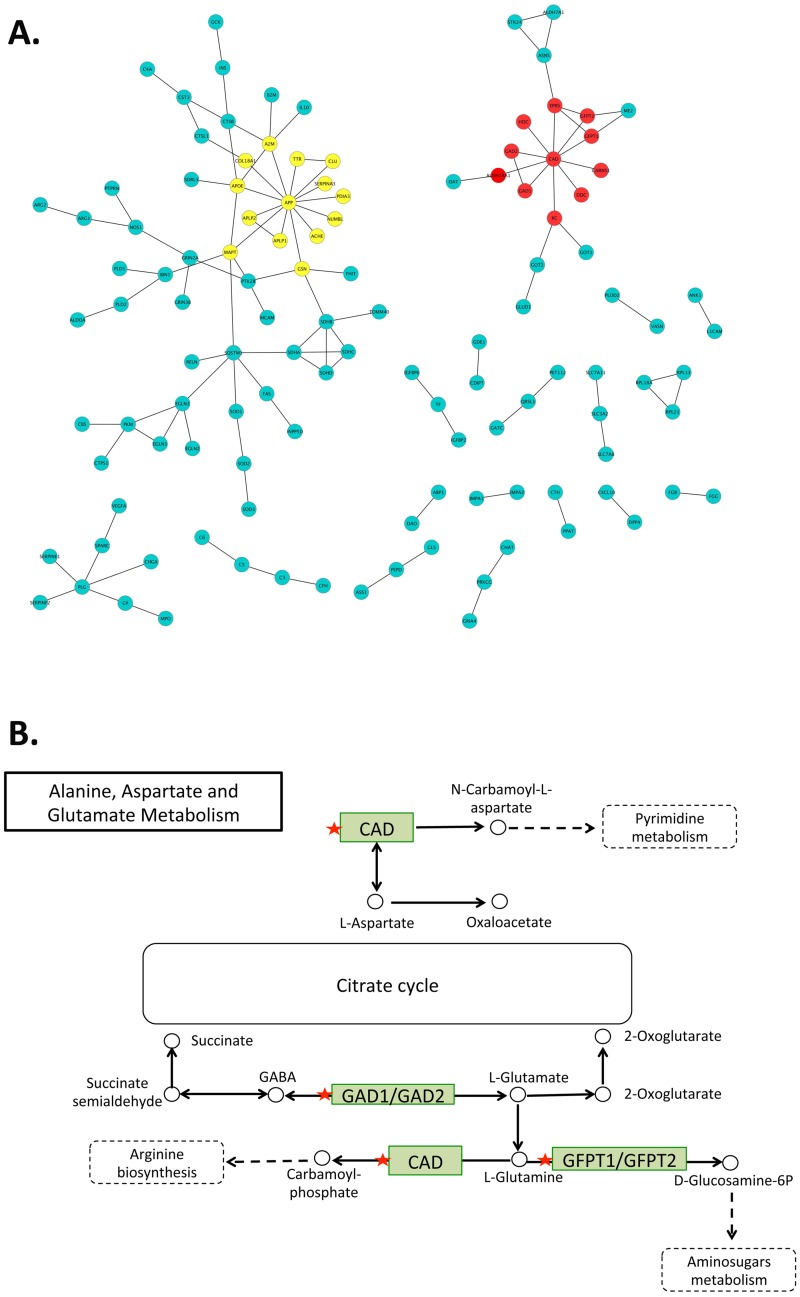
A) Protein-protein interaction analysis of 524 AD-related proteins revealed two large protein clusters: the APP network (14 yellow nodes) and the CAD network (11 red nodes). B) The functional enrichment analysis found that five proteins (labeled with red stars) of the CAD network are involved in the “Alanine, Aspartate and Glutamate Metabolism” pathway (CAD, GAD1, GAD2, GFPT1, GFPT2). The figure was generated based on the results obtained by the David online tool and the KEGG database.